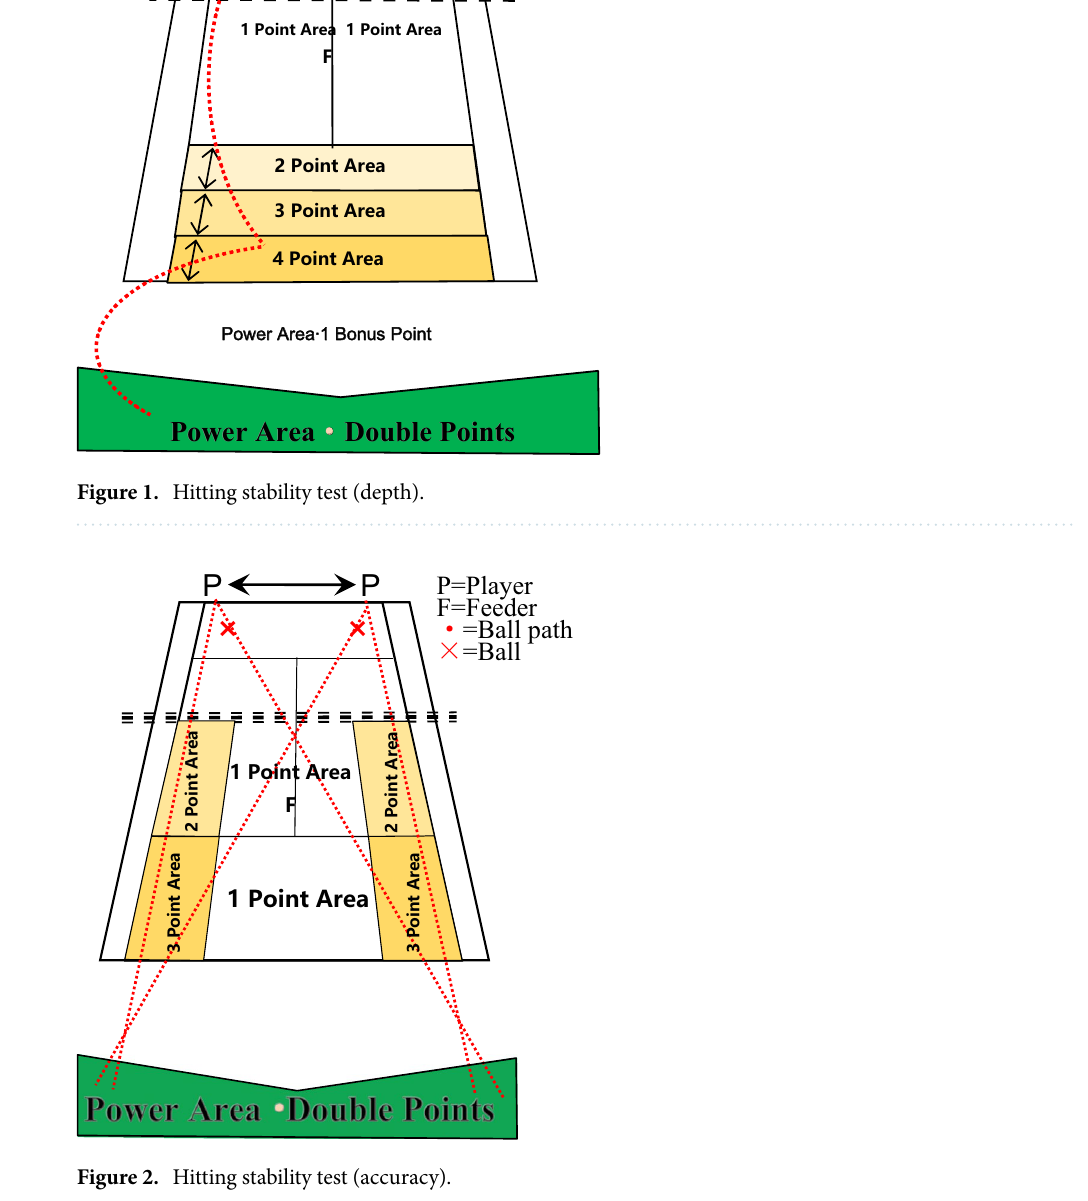
Hitting stability test.